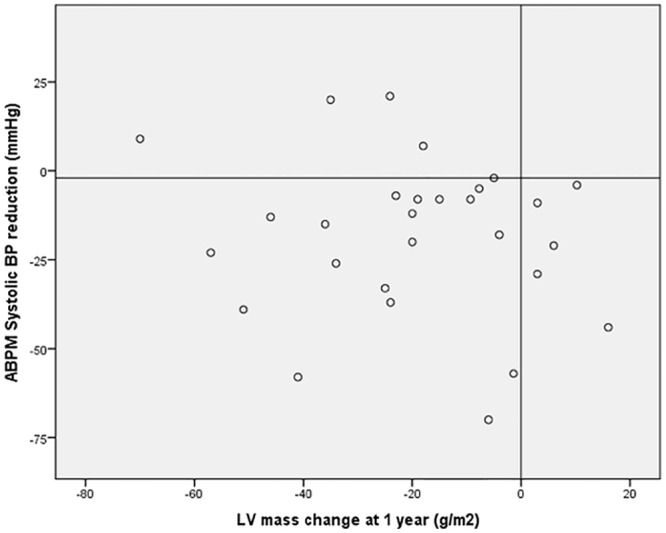
Relation between LV mass index and ABPM systolic BP changes at 1 year follow-up.Horizontal line set at 2mmHg for responder in ABPM systolic BP reduction. Five patients had regression in LVMI without significant (>2mmHg) reduction in ABPM systolic BP and 5 additional patients were ABPM systolic BP responders but without reduction in LVMI. BP- blood pressure; ABPM –24 hours ambulatory blood pressure measurement; LV—left ventricle.